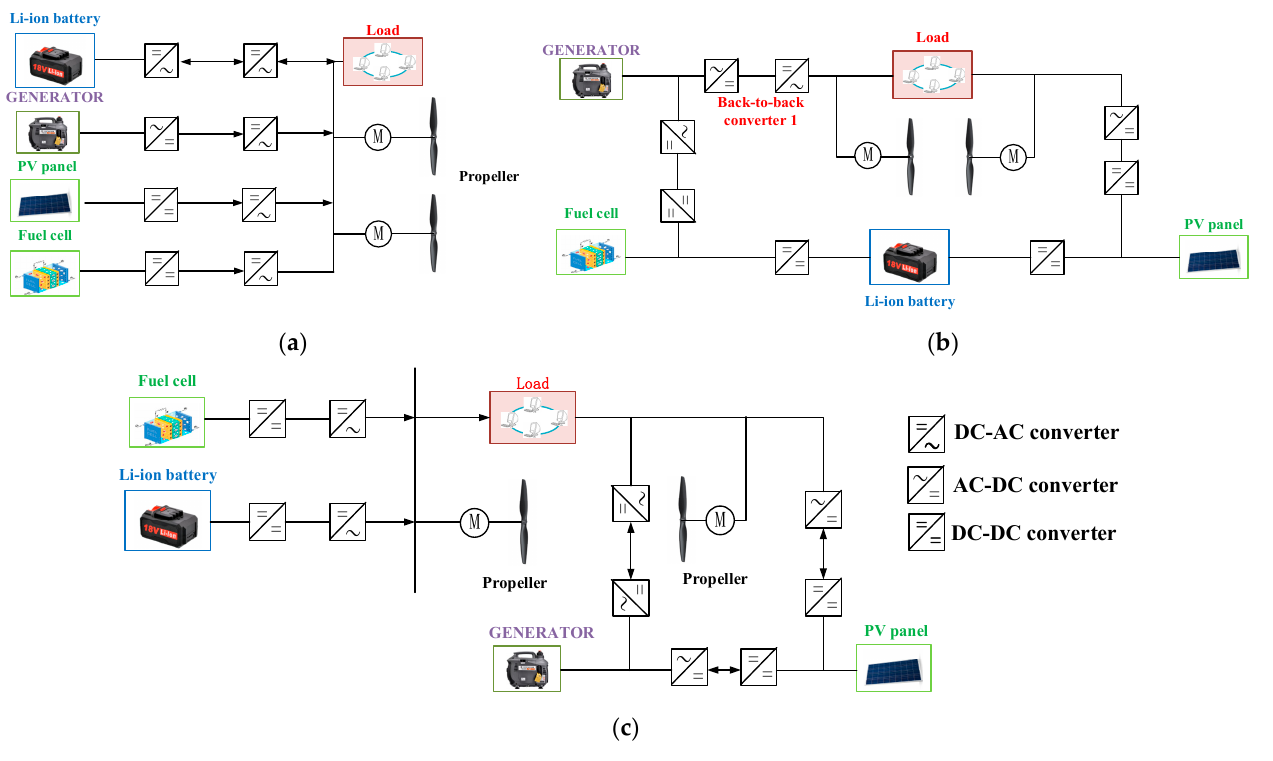
Figure 12. The different architecture of electrical power system in aircraft microgrid. ( a ) The star architecture of aircraft microgrid structure; ( b ) The ring architecture of aircraft microgrid structure; ( c ) The hybrid architecture of aircraft microgrid structure.